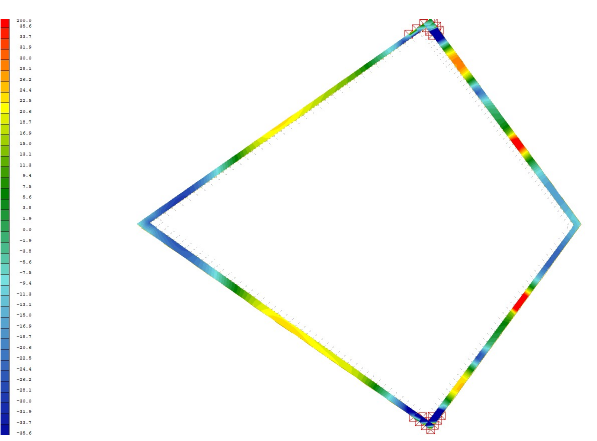
Figure 20: Edge beam bending moment, M max = 36 kN/m (red) and M min = − 26 kN/m (blue)